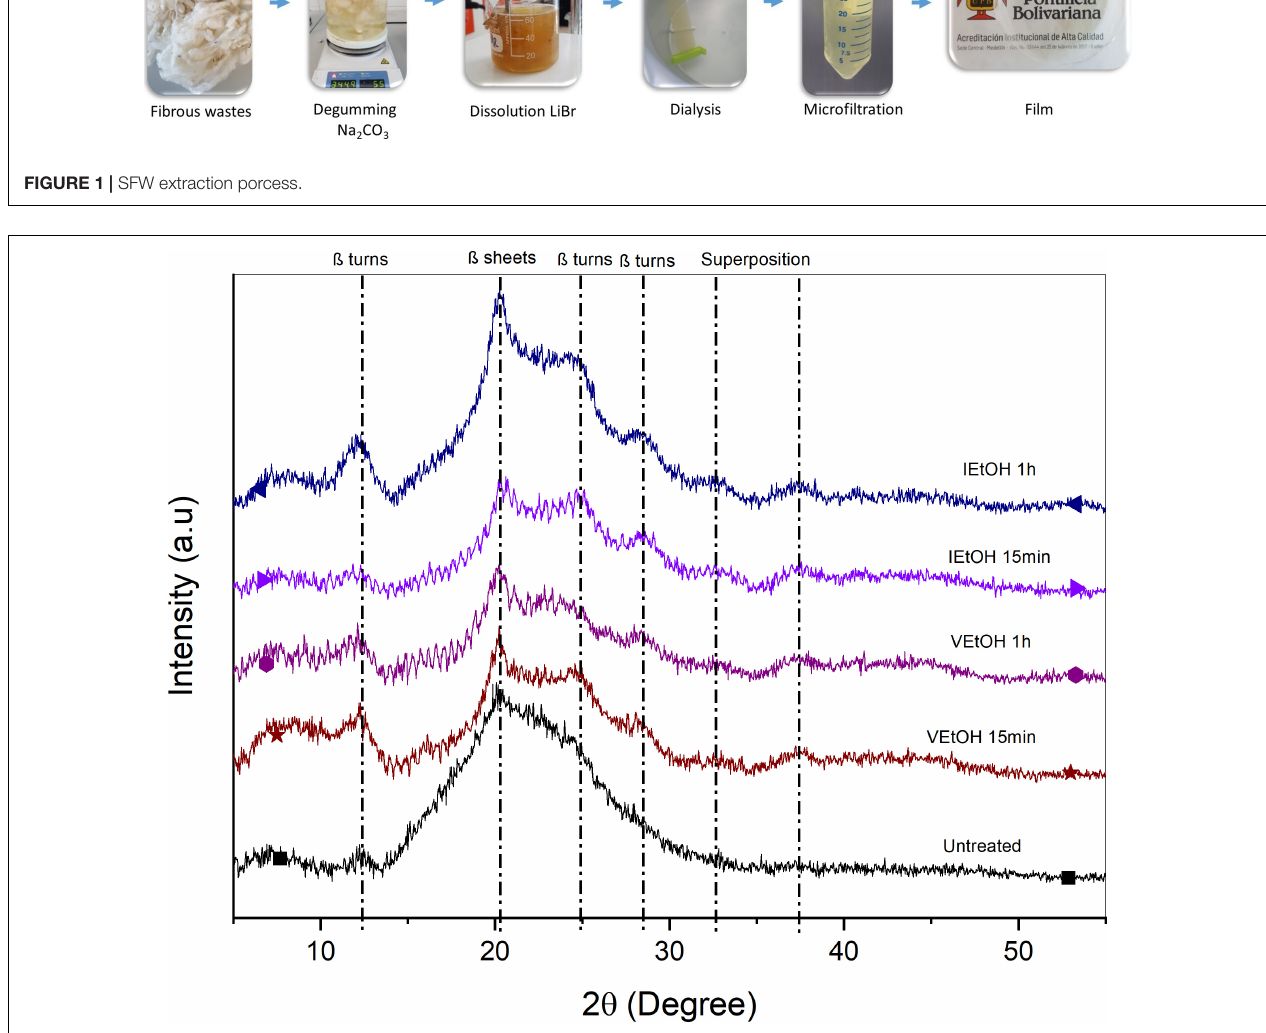
FIGURE 2 | XRD untreated and treated films with